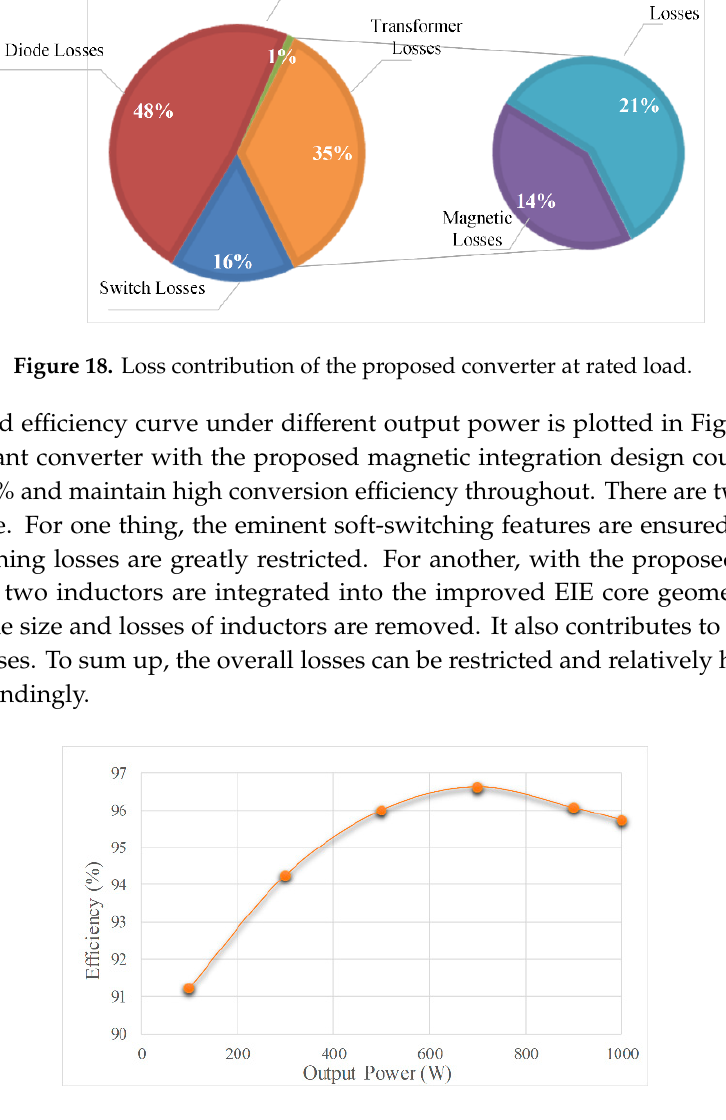
Figure 19. Efficiency curve under different output power. Figure 19. E ffi ciency curve under di ff erent output